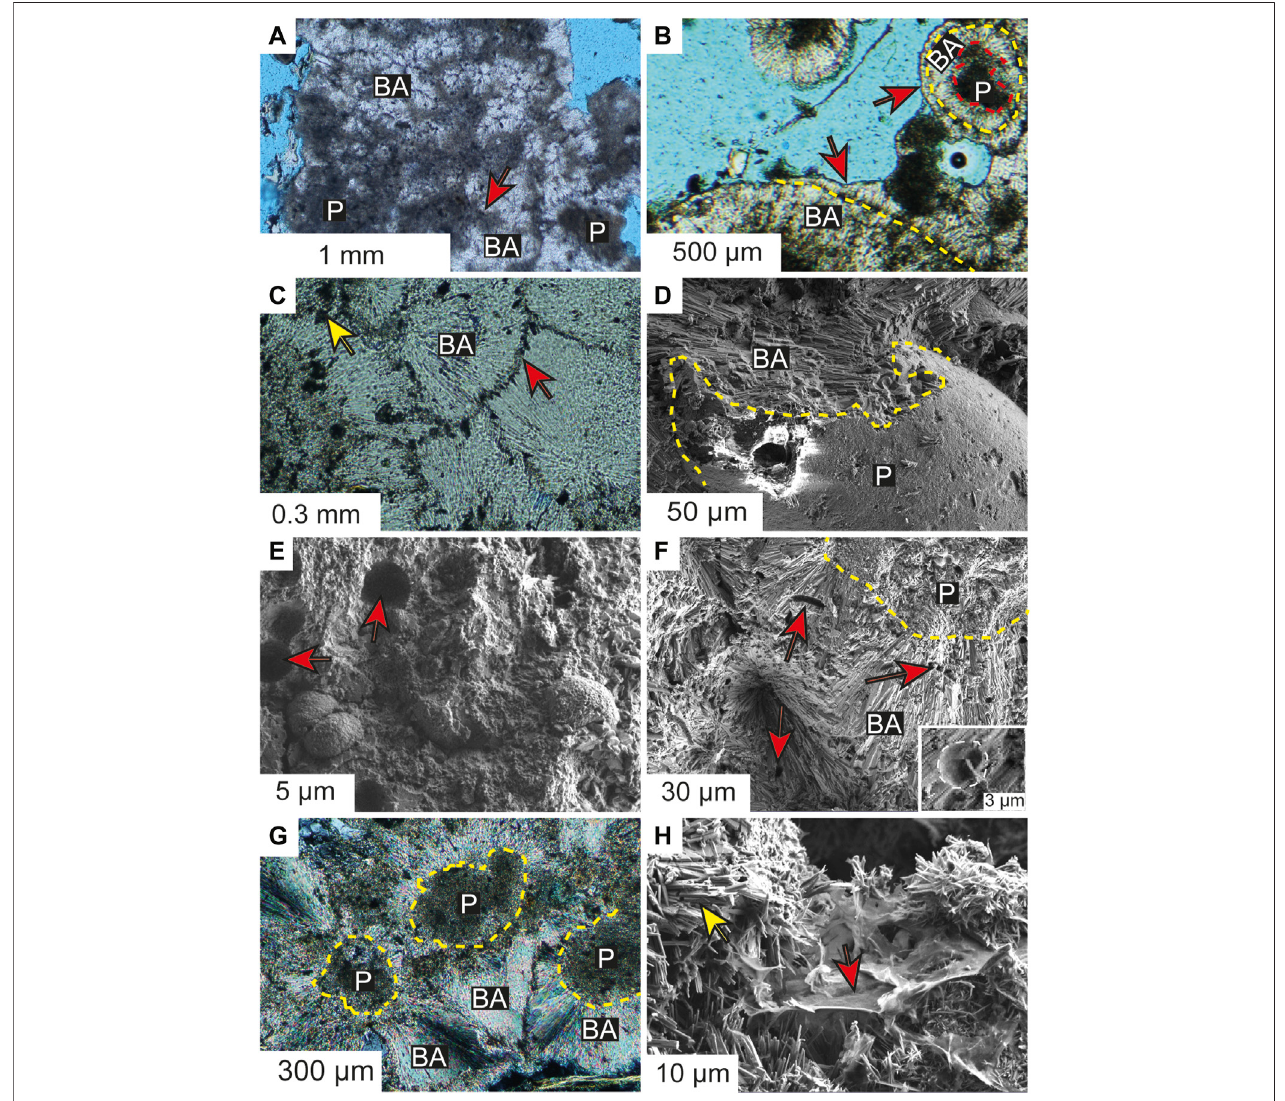
FIGURE 5 | Petrological features of botryoidal and spherulitic aragonite and co-existing early marine cement at Abu Dhabi (A) Botryoidal aragonite (BA) grows within carbonate sediment and shows irregular contacts (indicated by red arrow) with peloidal nuclei (P) (B) Botryoidal aragonite (BA) radiates around peloidal nuclei (P) and is partly covered by interstitial marine cements (indicated by red arrows) (C) High magni fi cation image of botryoidal aragonite (BA) showing various amount of inclusions (yellow arrow) and irregular contacts (red arrow) among adjacent mamelons (D) Under SEM, botryoidal aragonite (BA) consisting of fi brous crystals replacesandcrossesapeloid(P) (E) Peloidswithmicroborings (redarrows) (F) Botryoidalaragonite(BA)containingsimilarmicroborings(redarrows)tothatofpeloidsin (E) .Enlargementofboredholesinthesmallinsert.Notetheregularandsmoothcontactsbetweenthewallsofboringsandthe fi brouscrystals,(e.g.inthesmallinsert) (G) Under crossed polarizers, botryoidal and spherulitic aragonite show sweeping extinction (H) Early marine cements (yellow arrow) in the pore space, showing random distribution and association with bio fi lm EPS (red arrow).